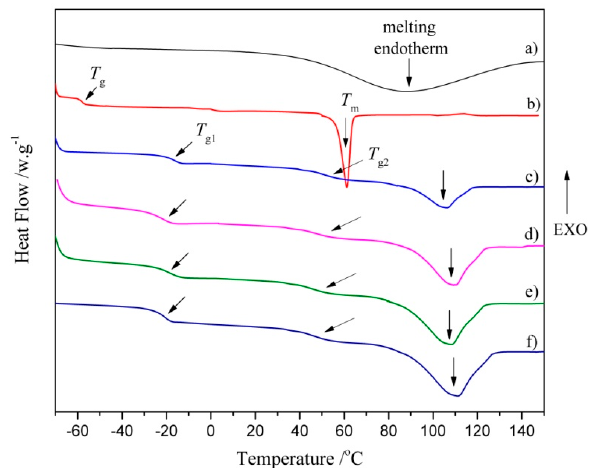
Figure 3. Differential scanning calorimeter DSC thermograms of ( a ) COS; ( b ) poly( ε -caprolactone) PCL; Table 2. The thermal transition temperatures of COS, PCL, and CPUs.